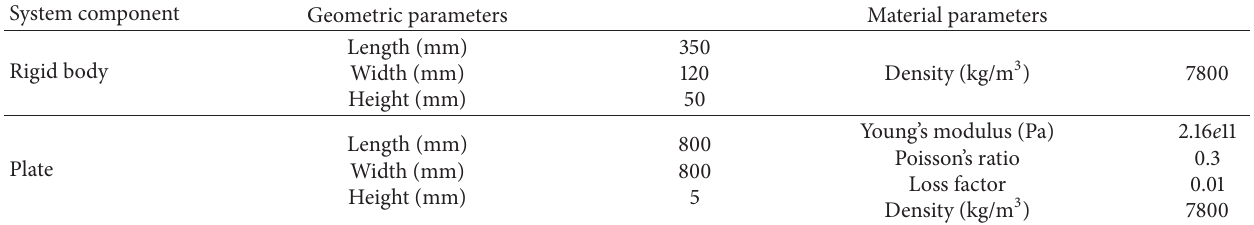
Table 1: Geometric and material parameters of the vibration isolation system.